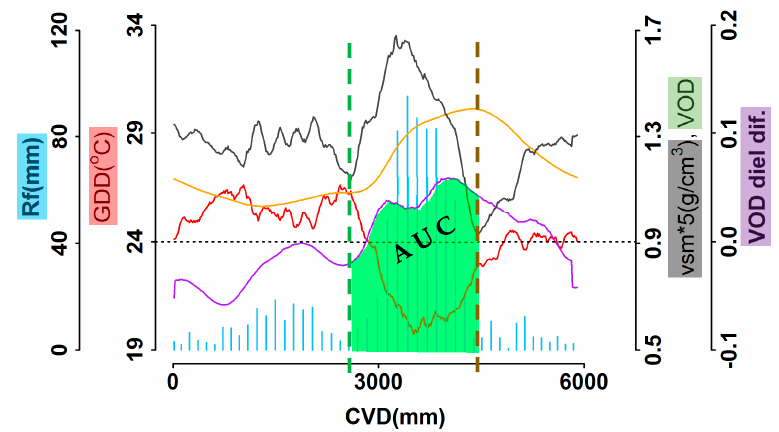
Figure 4. AUC (area under the curve) of VODdd (vegetation optical depth diel difference; green area under the purple curve) at AMSR pixel cropland site in Ethiopia (Site 82). The cut points were determined based on the seasonality of volumetric soil moisture.